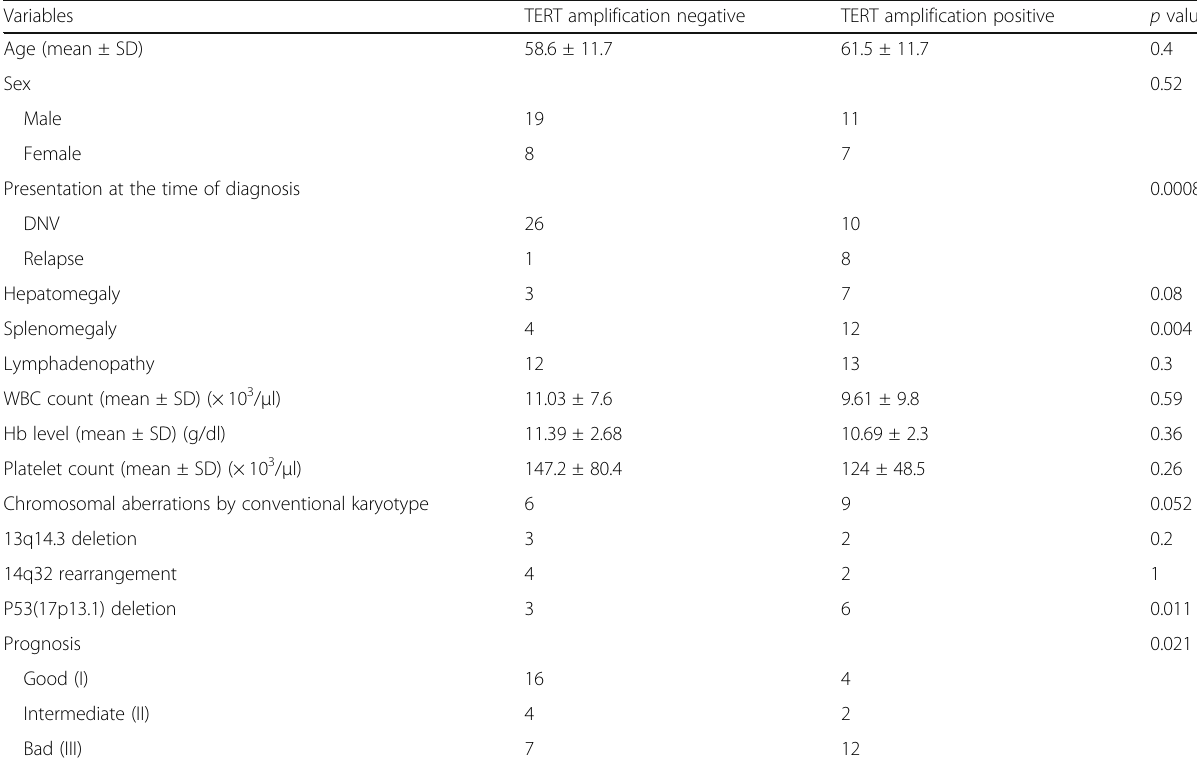
Table 7 Association between TERT gene amplification and clinicopathological and cytogenetic characteristics of all patients Variables